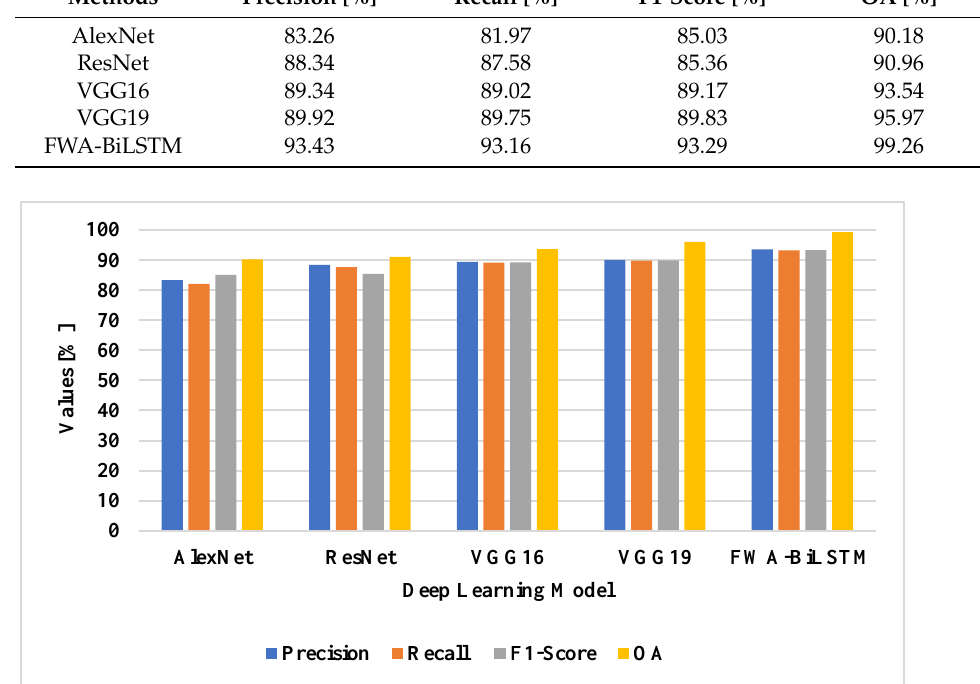
Figure 8. Performance of deep learning on LEVIR-CD dataset.